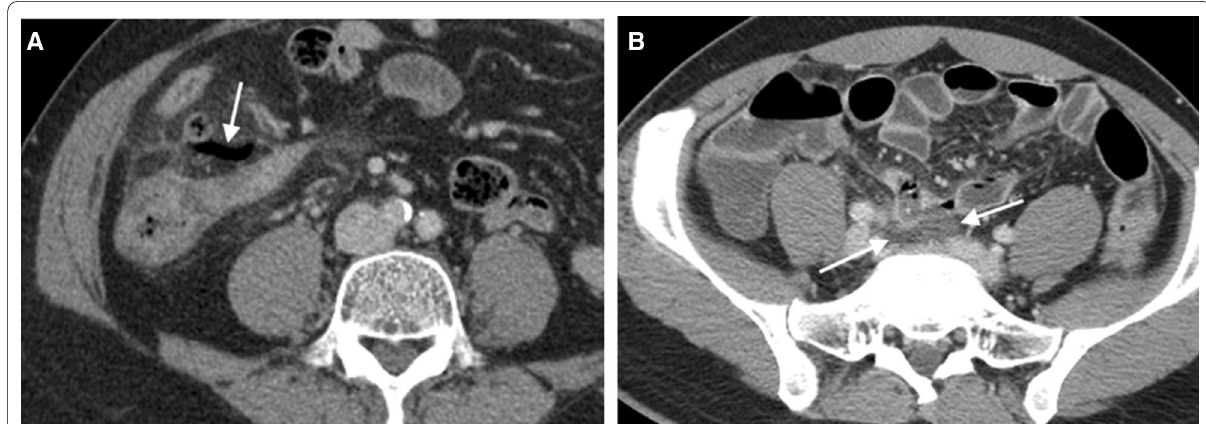
Fig. 9 Periappendiceal air and fluid. Axial CT images of two different patients show extraluminal air within mesoappendix (arrow in a ) and extraluminal periappendiceal fluid (arrow in b ). The former patient is a 73-year-old man who presents with abdominal pain and fever, slightly elevated white blood cell counts (11,370 cells/mm 3 ) and neutrophilia (88.0% neutrophils). The latter is a 39-year-old-man presenting with right lower abdominal pain for 1 day, elevated white blood cell counts (17,100 cells/mm 3 ) and neutrophilia (86.8% neutrophils). Both have a confirmed diagnosis of perforated